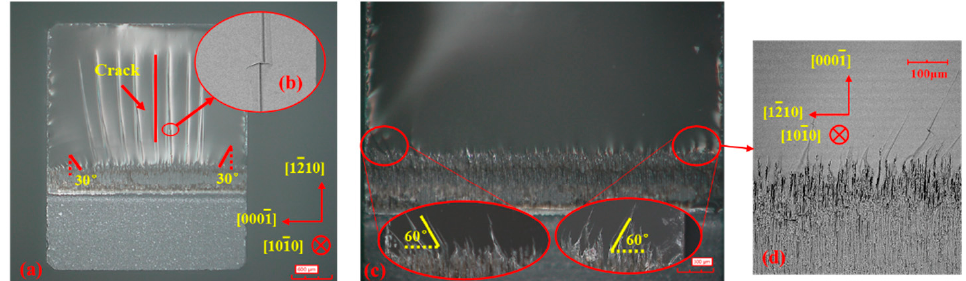
Figure 8. Morphology of the fractured surface in M-plane sapphire tests. ( a ) Fractured surface of M-A tests, “M” is the cross-section of the sapphire sample, “A” is the loaded surfaces. ( b ) Small transverse steps along cracks. ( c ) Fractured surface of M-C tests, “M” is the cross-section of the sapphire sample, “C” is the loaded surfaces. ( d ) Local cracks.